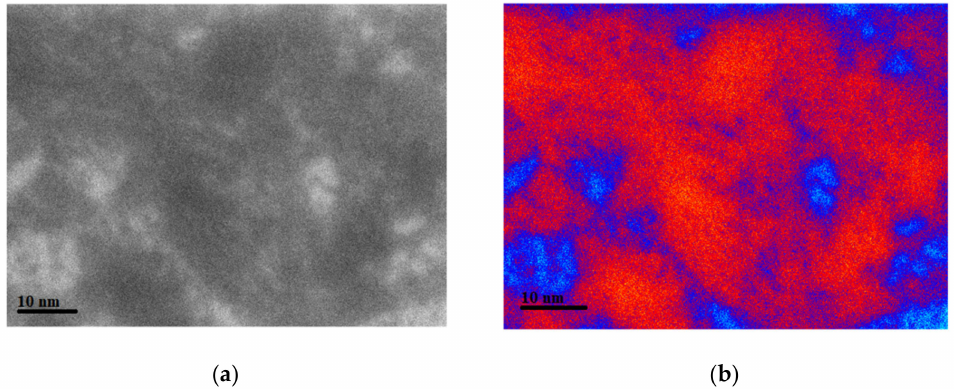
Figure 6. Micrograph images of a thin, solid film sample studied, showing the surface in bright color. ( a ) TEM micrograph image before the ablation takes place. ( b ) Heat distribution (numerical simulation) over a small area interacting with the nanosecond single beam at 532